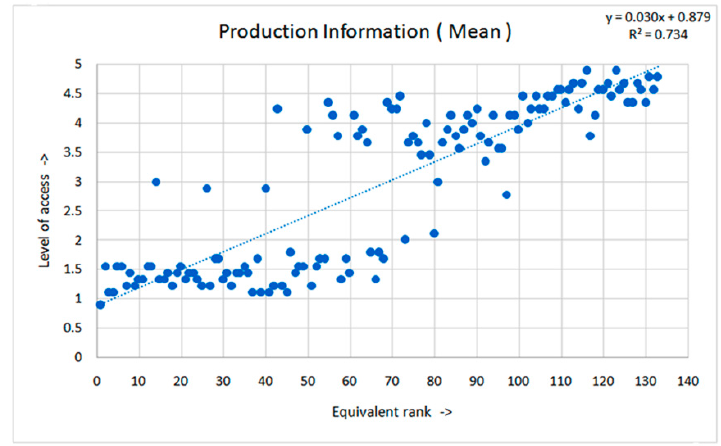
Figure 4. Level of access of production information (mean) vs. equivalent ICT rank.